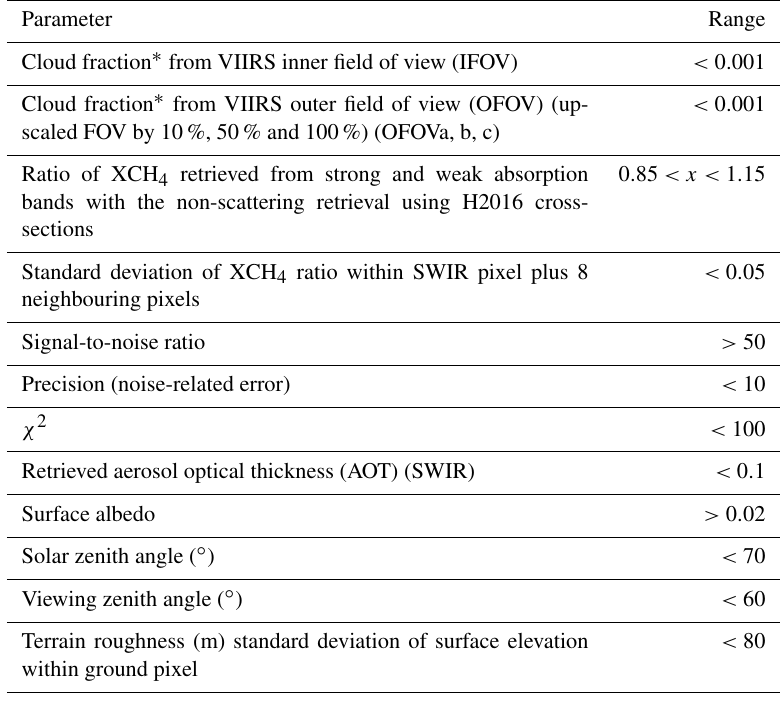
Table A1. Overview of the filters applied to ensure high-quality TROPOMI XCH 4